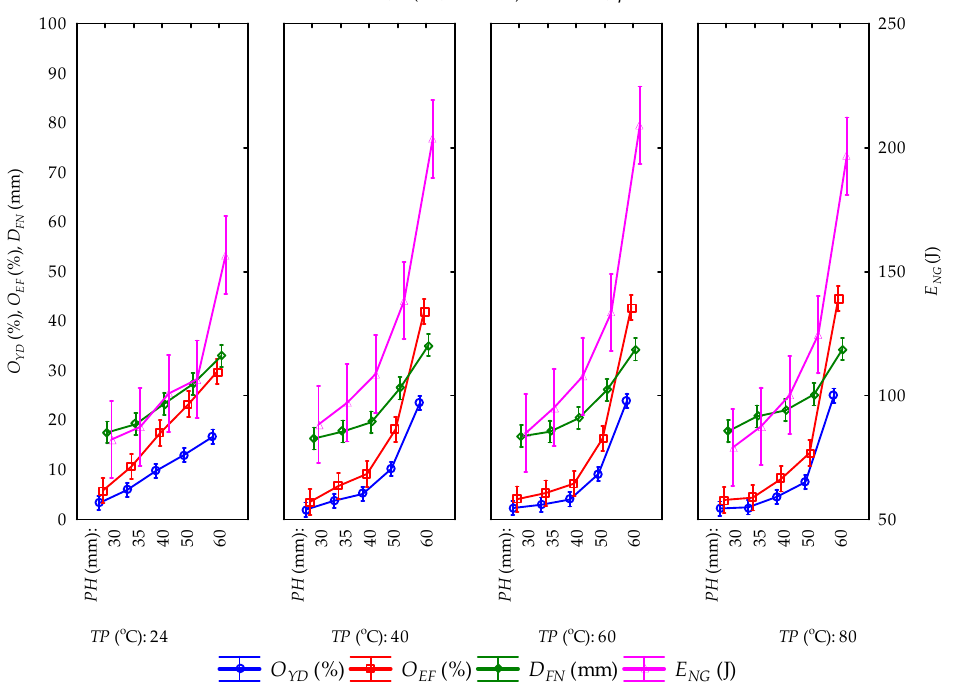
Figure 5. Least square means of the calculated parameters and their factors' interactions (vertical bars denote 95% confidence interval; PH : pressing height; TP : temperature; (cid:1841) (cid:3026)(cid:3005) : oil yield; (cid:1841) (cid:3006)(cid:3007) : oil expression efficiency; (cid:1830) (cid:3007)(cid:3015) : deformation; (cid:1831) (cid:3015)(cid:3008) : energy).